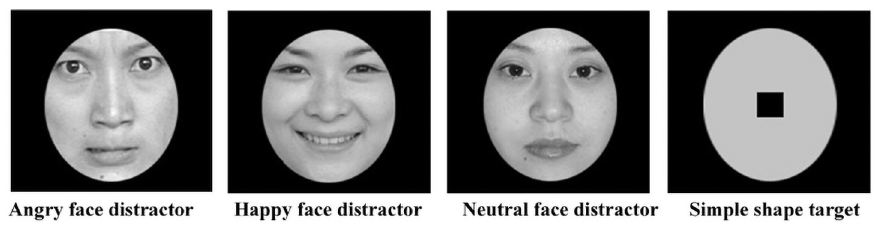
Fig 1. Three categories of emotional face distractor examples and the simple shape target used in the RDP task. The face images were taken from the Chinese Affective Face Picture System (CAFPS, Wang & Luo, 2005, Gong, Huang, Wang, & Luo, 2011), and all the face models in the CAFPS gave their consent for publication for research purposes.